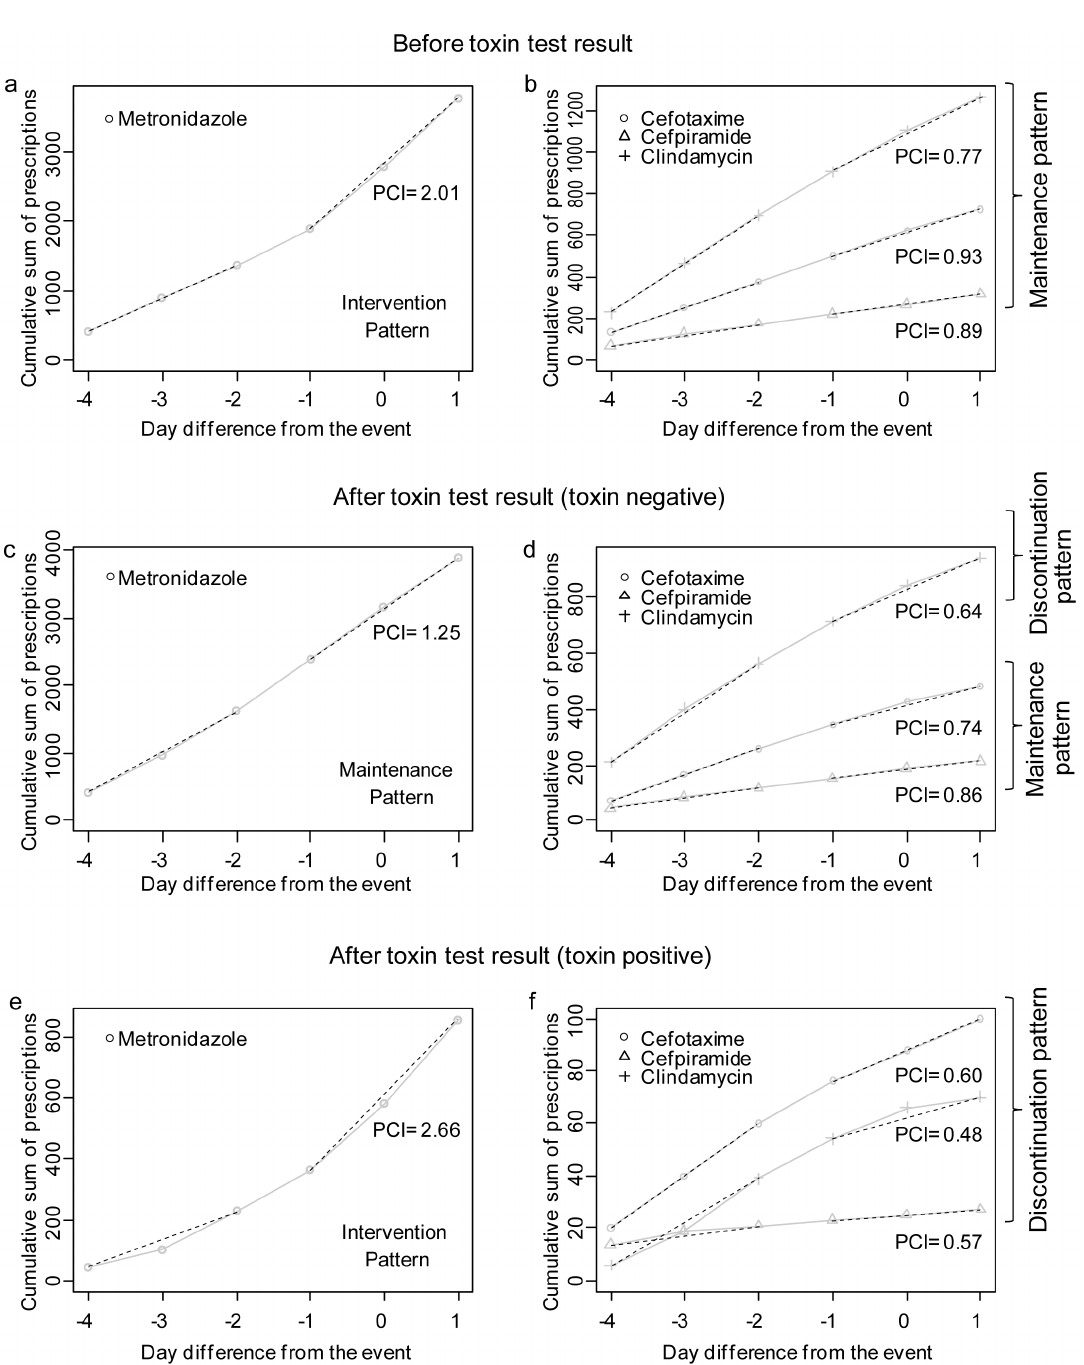
Figure 3. Changes in prescription patterns according to Clostridiumdifficile -associated diarrhea (CDAD). (a) and (b): Prescription patterns of metronidazole (a), cefotaxime, cefpiramide, and clindamycin (b) on the day on which a C. difficile toxin test was ordered (before the toxin test result). (c–f): prescription patterns on the day on which toxin test results were confirmed; (c) and (d): C. difficile toxin negative; (e) and (f): C. difficile toxin